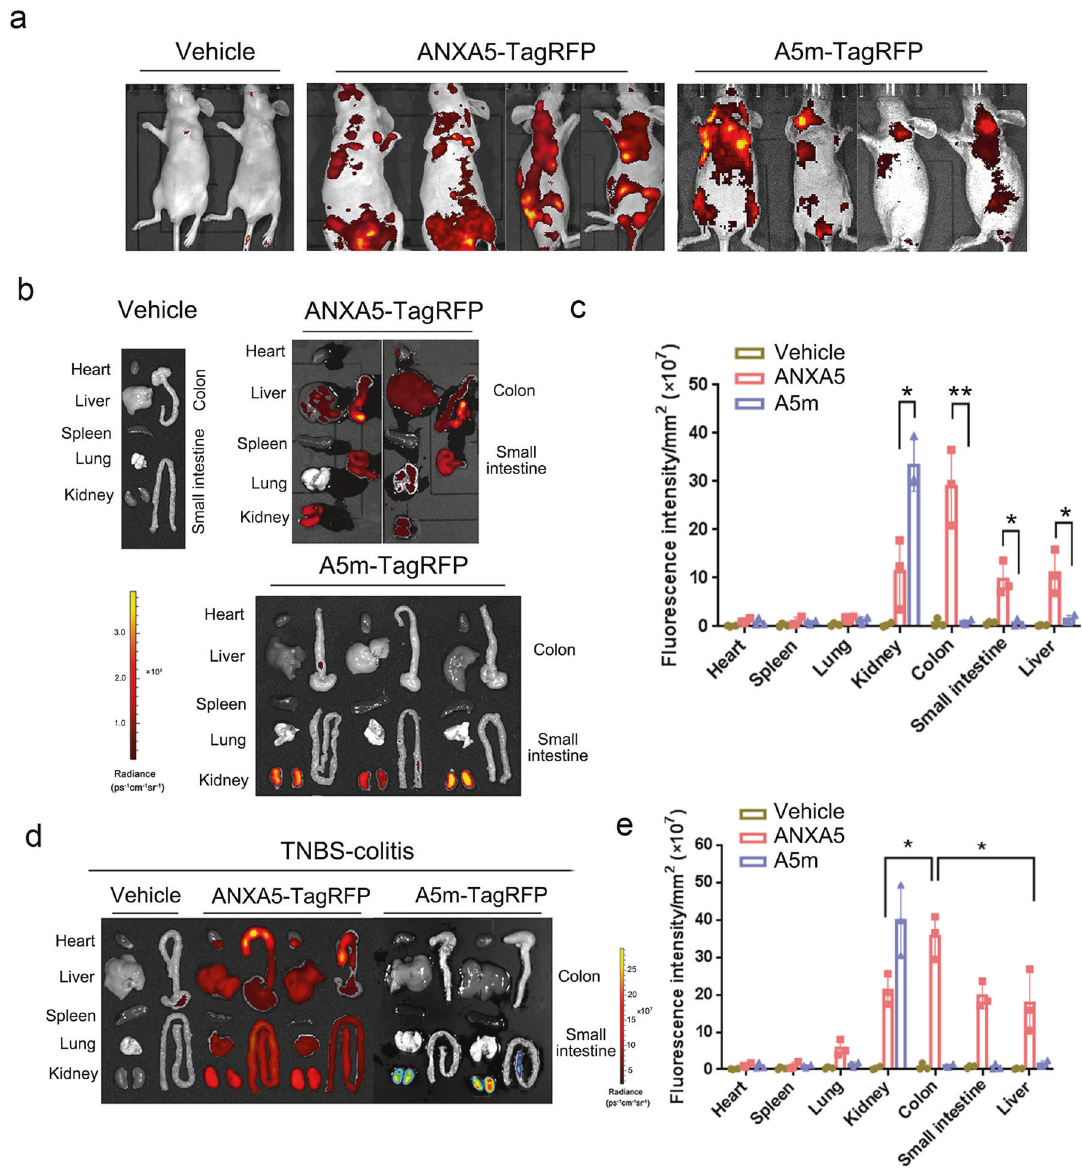
Fig. 3 ANXA5 targeting to the colon in a PS-dependent manner. a Nude mice were injected with ANXA5/A5m-TagRFP by tail vein ( n = 3). After 30 min, in vivo imaging of fl uorescent proteins was visualized by IVIS Lumina XR system. b Ex vivo imaging of ANXA5/A5m-TagRFP in various tissues was visualized after dissection. Red to yellow color indicates increased fl uorescence intensity. Fluorescence intensity of various tissues was quantitatively analyzed in ( c ). * P < 0.05, ** P < 0.01 versus the control group according to Student ’ s t tests. d BALB/c mice with TNBS colitis were injected with ANXA5/A5m-TagRFP by tail vein ( n = 3). After dissection, Ex vivo imaging of ANXA5/A5m-TagRFP in various tissues was visualized, and quantitatively analyzed in ( e ). Data are represented as mean ± SD. * P < 0.05 versus the control group according